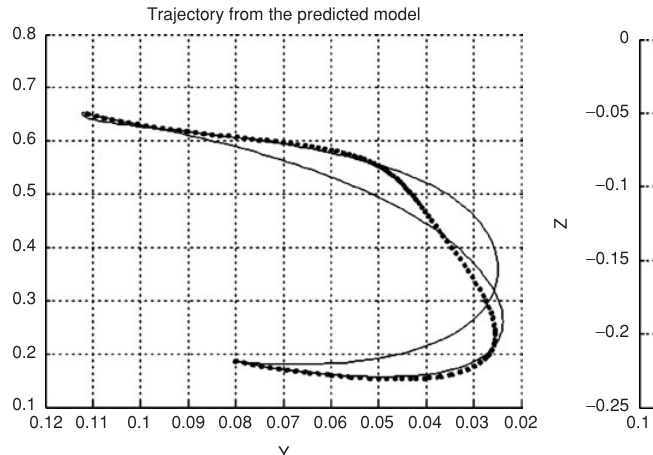
Figure 16 represents the wrist trajectory in the XY (a) and XZ (b) planes given by the predicted model for the 15 cm obstacle heights in P1and P2 position.